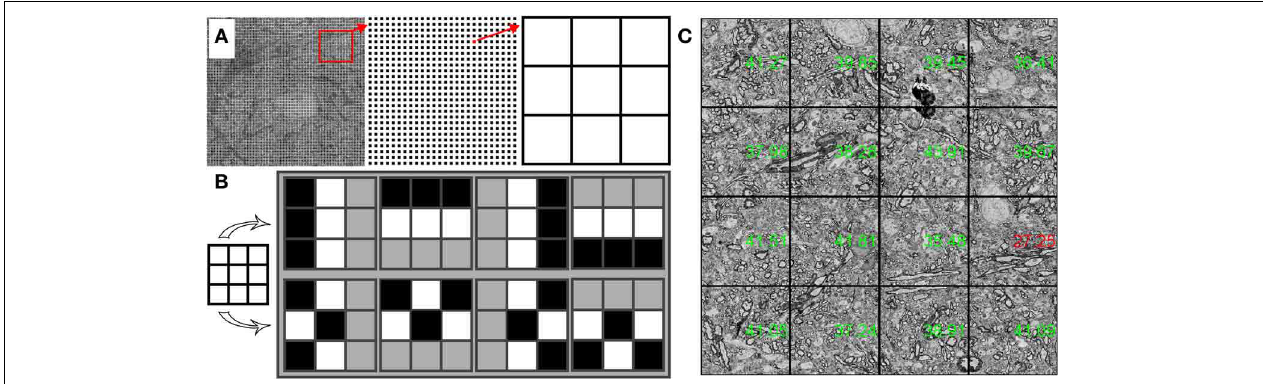
FIGURE 8 | Structure of quality check procedure. (A) A 200 × 200 array of 3 × 3 pixel kernels is extracted from an SEM image. (B) Structured (top) and unstructured (bottom) contrast patterns are compared to obtain